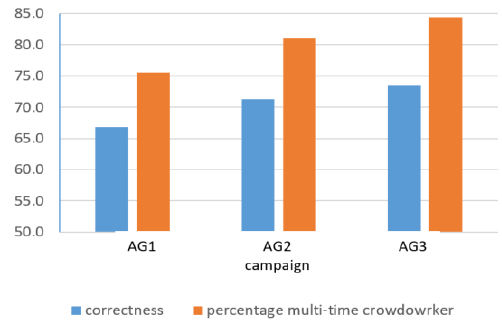
Figure 10 . Correctness compared to percentage of multi-time crowdworkers.